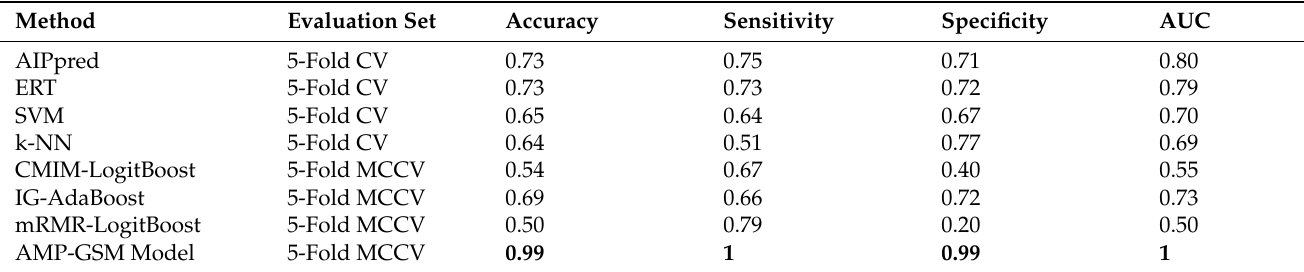
Table 10. Performance evaluation of AMP-GSM with other traditional feature selection and classifica- tion models for Dataset 3